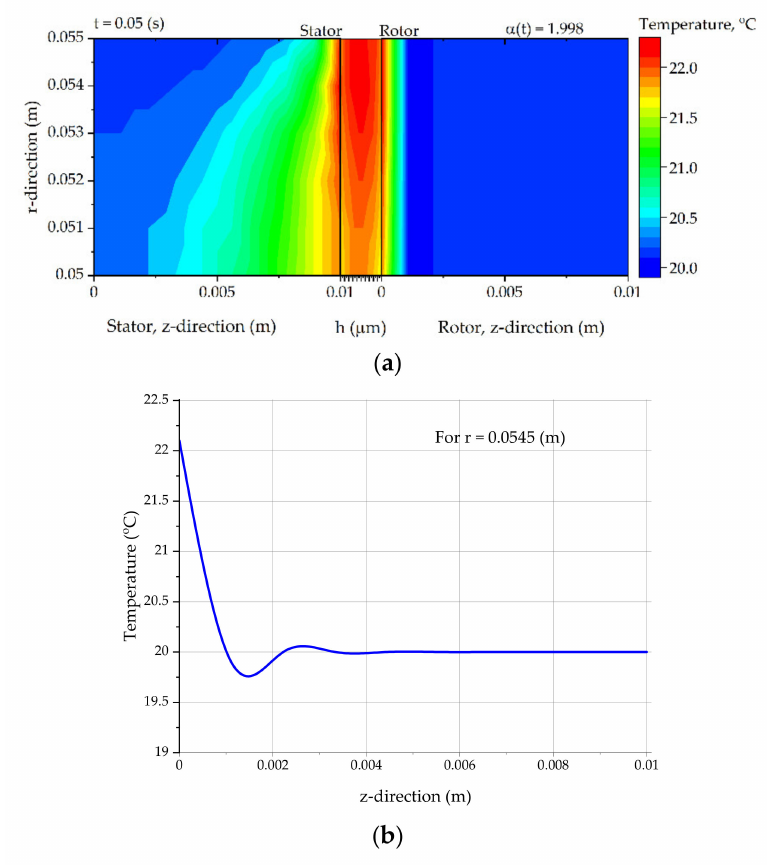
Figure 5. ( a ) Distribution of temperature in the seal for t = 0.05 (s) and α = 1.998, ( b ) temperature vs. the rotor thickness for r = 0.0545